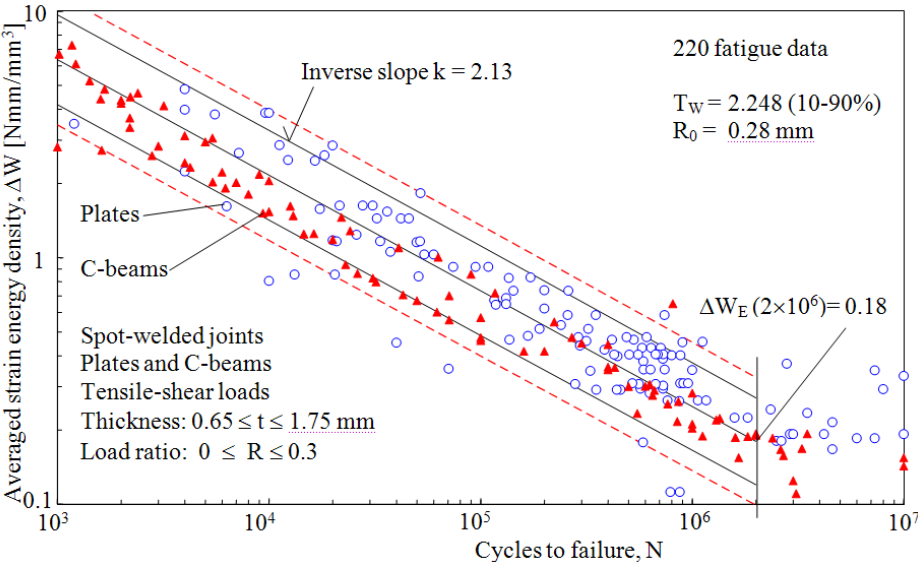
Figura14: Banda di dispersione relativa a giunti a sovrapposizione saldati a punti soggetti a sollecitazioni di trazione/taglio (piatti e travi a C). Valori di  W determinati da modelli tridimensionali.